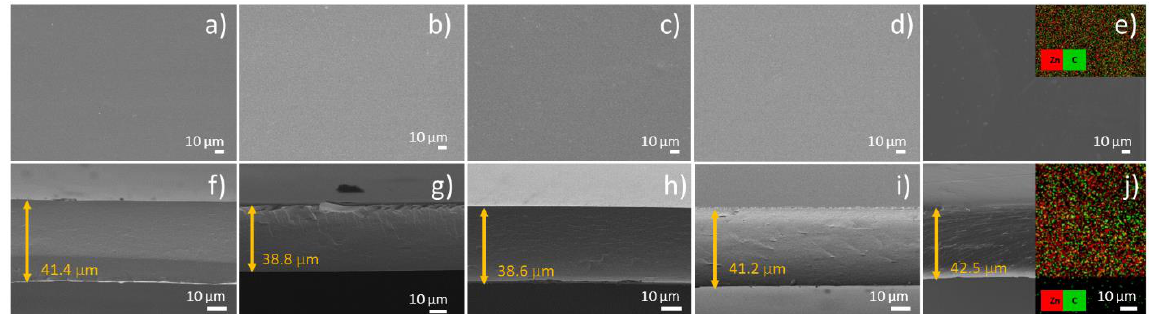
Figure 2. Scanning electron microscopy (SEM) images of the top ( a – e ) and cross-section view ( f – j ) of chitosan films functionalized with the green-synthesized ZnO NPs; film of ( a , f ) pure chitosan, films of chitosan with ( b , g ) 0.5% ( w / w ), ( c , h ) 1% ( w / w ), ( d , i ) 2% ( w / w ), and ( e , j ) 10% ( w / w ) of ZnO NPs; insets represent the elemental distribution of Zn and C in the film depicted by energy dispersive X-ray spectroscopy (EDS).